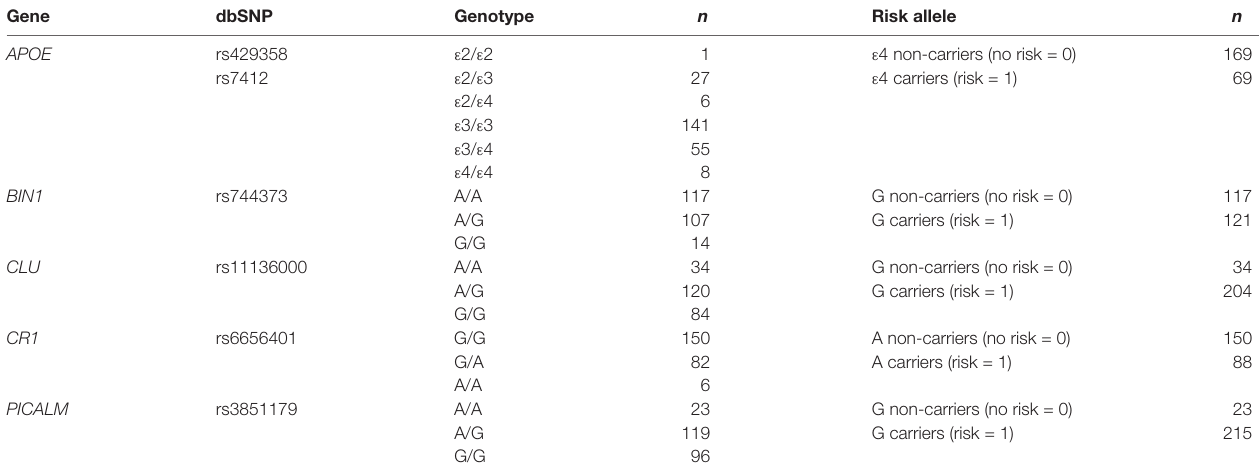
TABLE 1 | The number of individuals carrying each genotype and each risk category at each of the loci analyzed. Gene